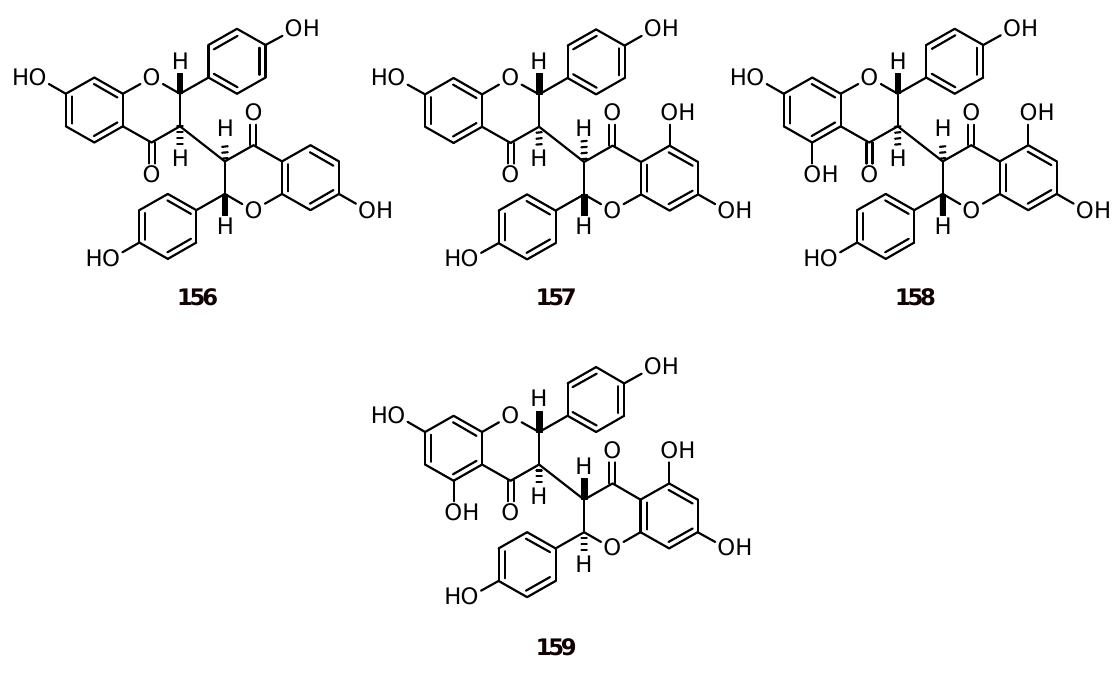
Figure 17 . Structures of biflavonoids 156 - 159